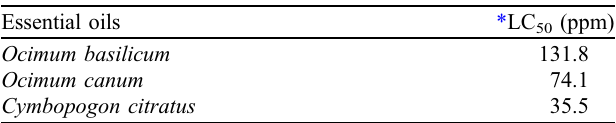
Table 4. Larvicidal activity of essential oils on the third-stage larvae of Anopheles funestus s.s.